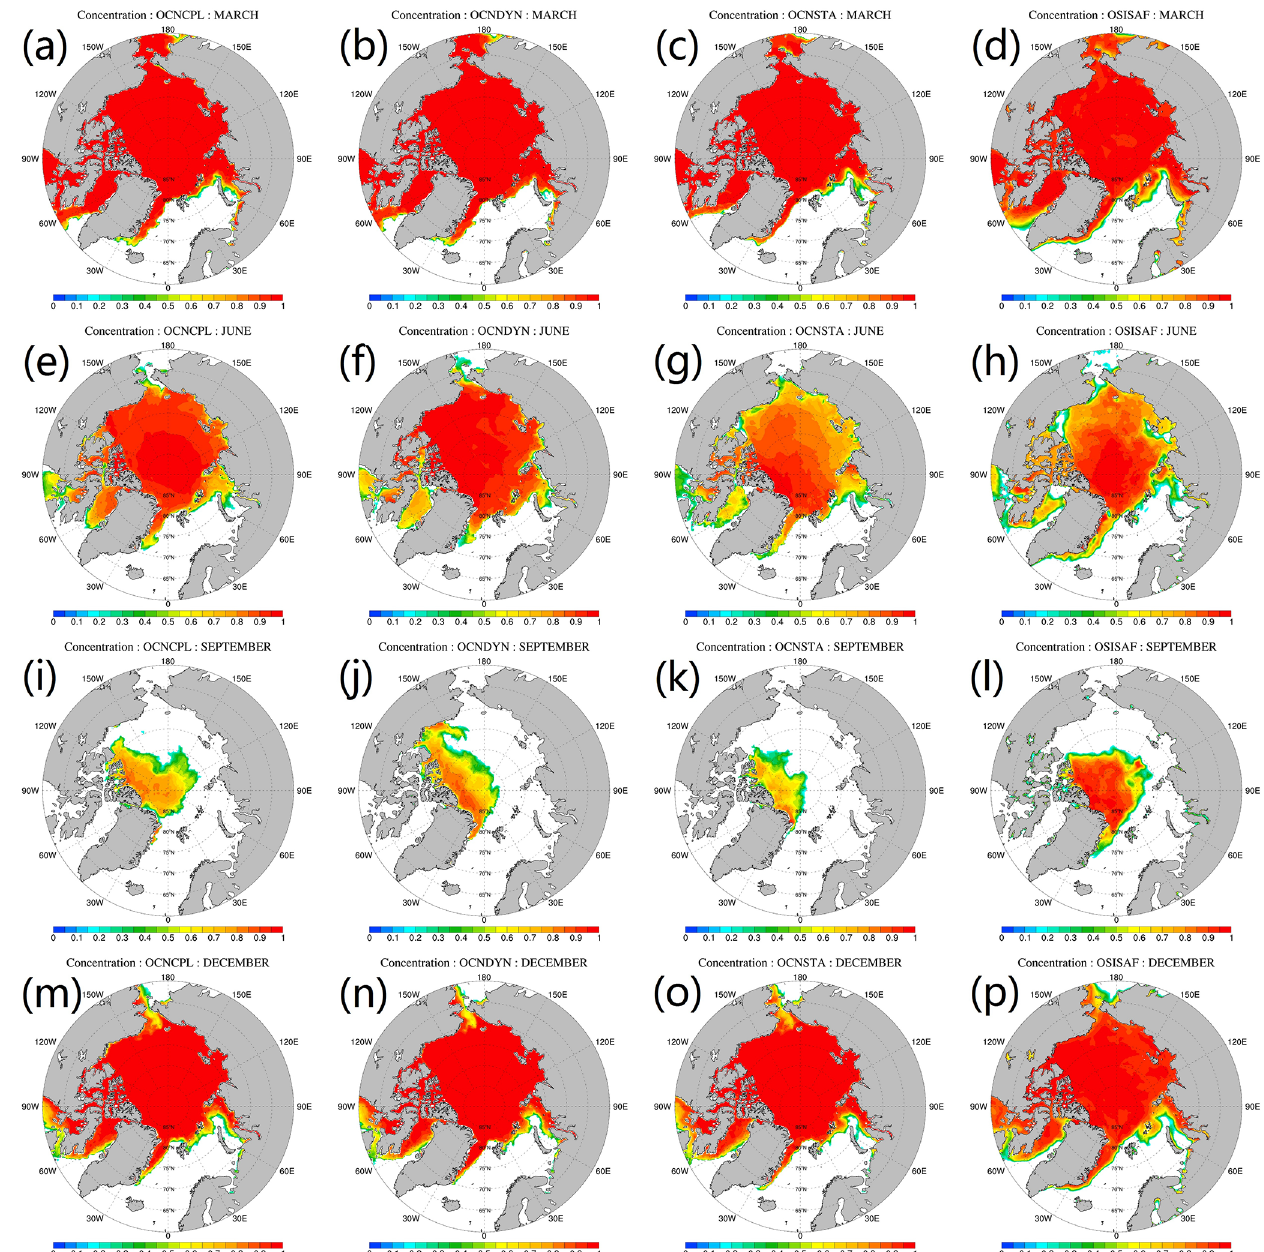
Figure 7. Modeled and observed monthly mean sea ice concentration. From top to bottom panels show the March, June, September and December sea ice concentration, respectively. From left to right panels show sea ice concentration of the OCNCPL run, the OCNDYN run, the OCNSTA run and the OSISAF observations. OSISAF: Ocean and Sea Ice Satellite Application